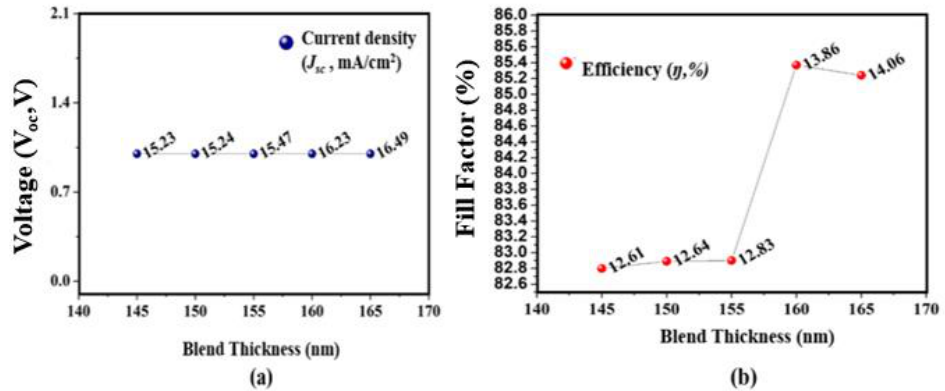
Figure 2. Effect of top active absorber layer thickness on photovoltaic parameters. ( a ) V oc and J sc ; ( b ) FF and η .